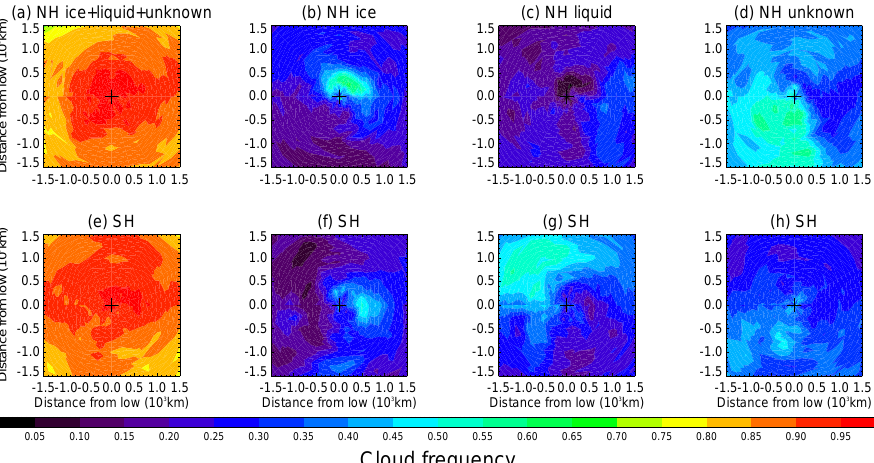
Fig. 16. Midlatitude cyclone composites of cloud frequency and ice, liquid, and unknown phase clouds for (a) – (d) the NH and (e) – (h) SH during January